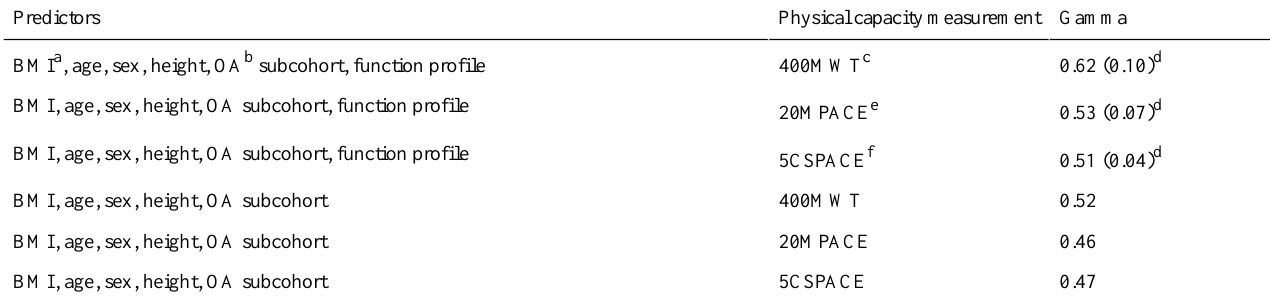
Table 2. Gamma for generalized additive models evaluated on held-out